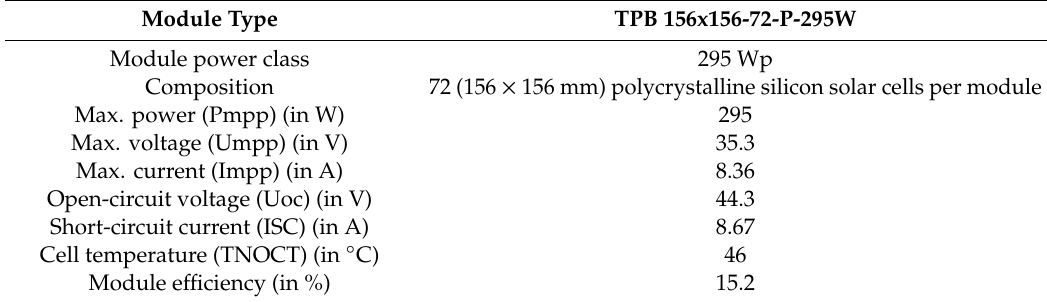
Table 1. Data sheet for the TPB